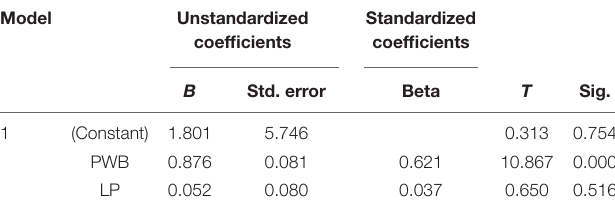
TABLE 6 | Coefficients for psychological well-being, loving pedagogy, work